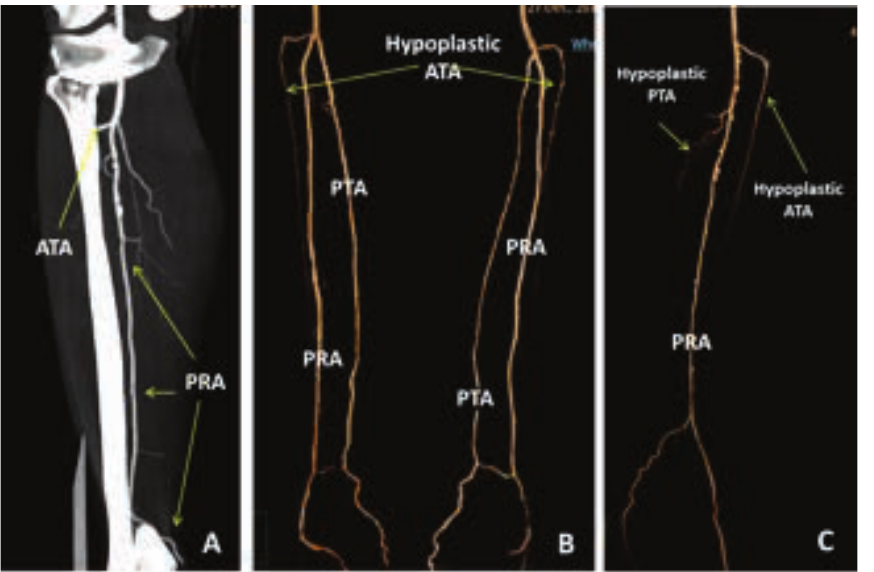
Figure 4: On the maximum intensity projection, (MIP) (A), and VR (B-C) MDCT images show the Type III branching pattern of the PA. Type IIIA pattern (A) in the right lower extremity; distal substitution of PTA by PRA, along with aplastic PTA. Type IIIB pattern (B) is seen bilaterally; hypoplastic ATA, and the distal ATA replaced by the PRA and concomitant Type IB pattern (B). Type IIIC pattern (C) in the left lower extremities; distal substitution of PTA and DPA by PRA in conjunction with hypoplastic ATA and PTA. Table 2: Distribution of variant patterns in 14 patients with bilateral involvement